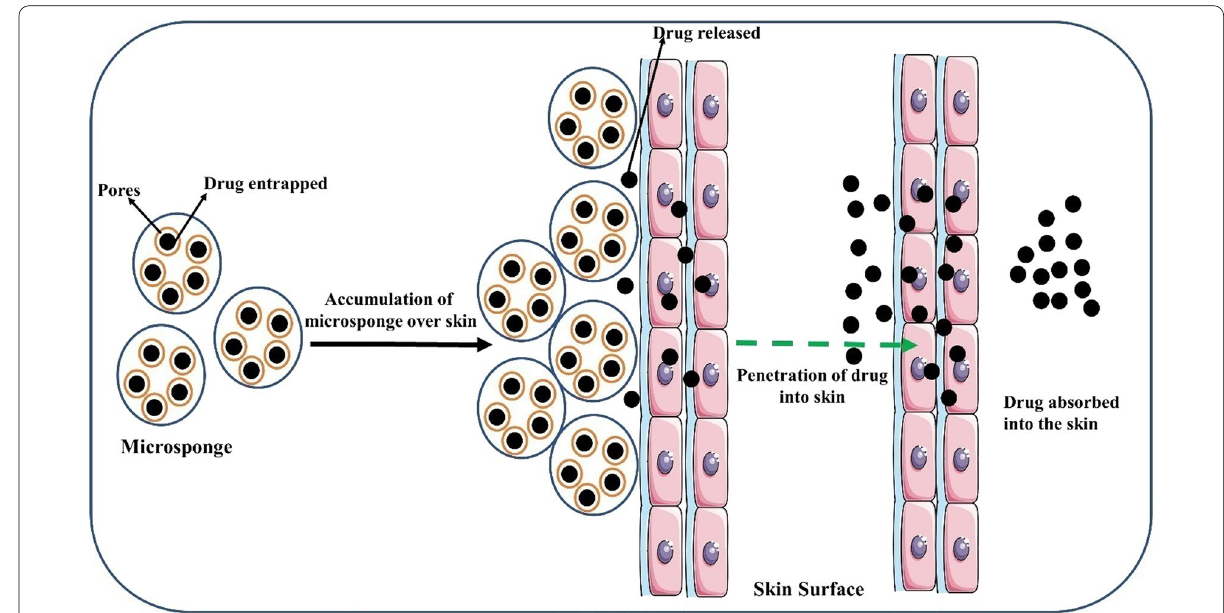
Fig. 8 Mechanisms of drug release from topical microsponges